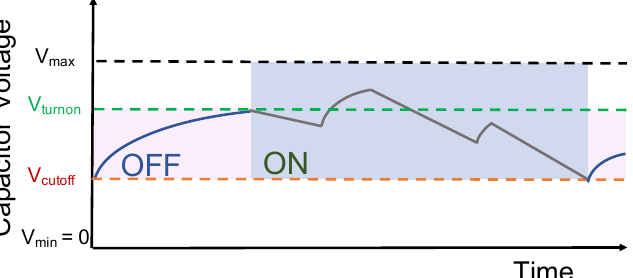
Figure 4. Intermittent behaviour of a batteryless LPN harvesting